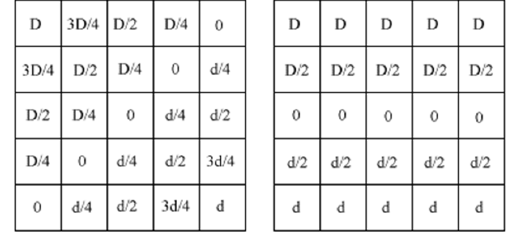
Figure 7 . Patterns according to the code 1 and 2 in a 5×5 moving